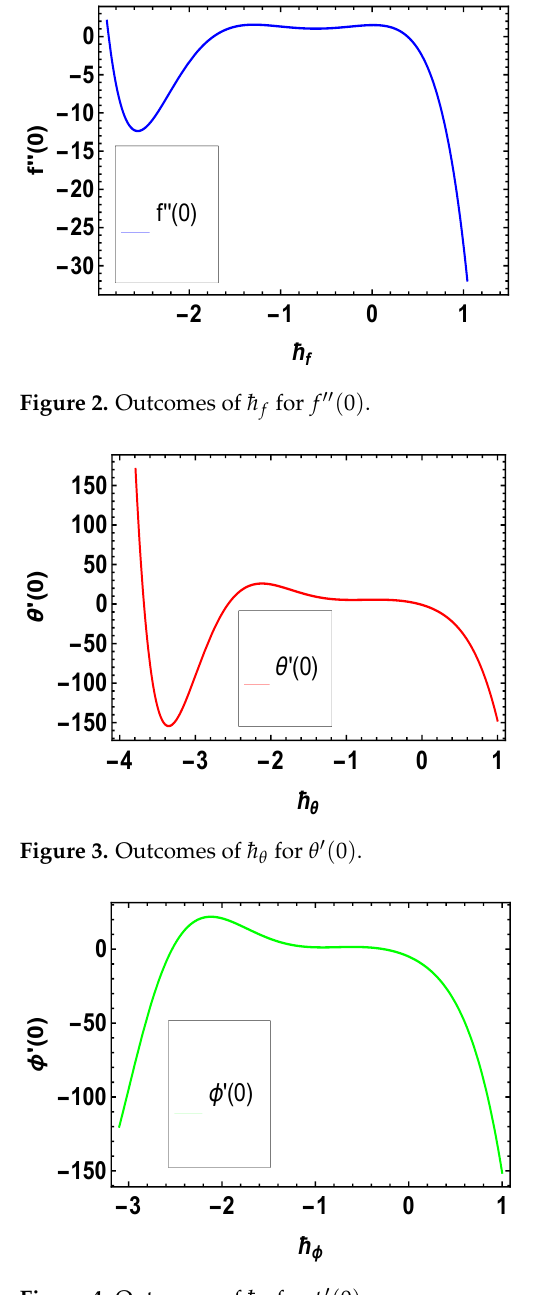
Figure 4. Outcomes of ¯ h φ for φ (cid:48) ( 0 )